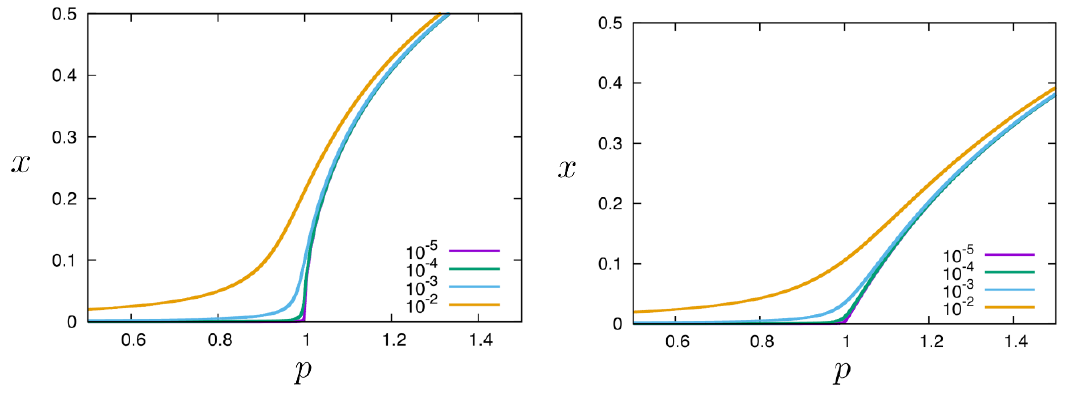
Figure 6 . x vs p with ~ s = 1 (left) and ~ s = 5 (right), ~ (cid:11) = 10 (cid:0) 2 ; 10 (cid:0) 3 ; 10 (cid:0) 4 and 10 (cid:0) 5 . We can